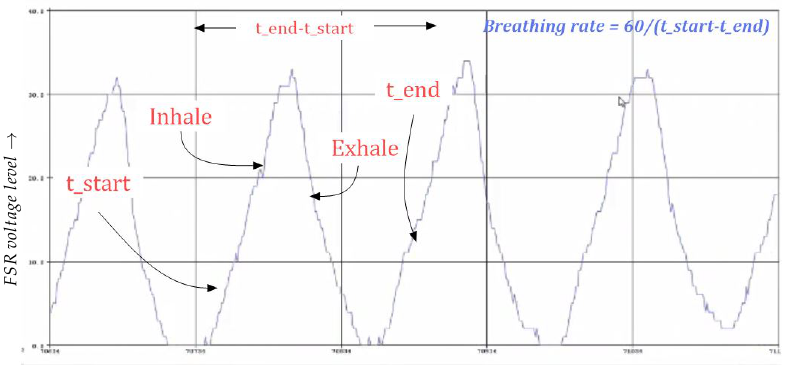
Figure 7. Breathing rate estimation algorithm visualization.